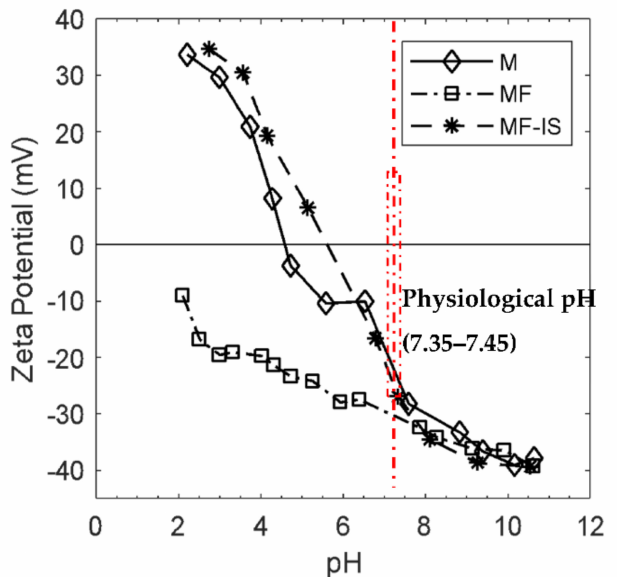
Figure 4. Zeta potential curves as a function of pH of magnetite (M), post-synthesis fucoidan-coated magnetite (MF), and in situ fucoidan-coated magnetite (MF −